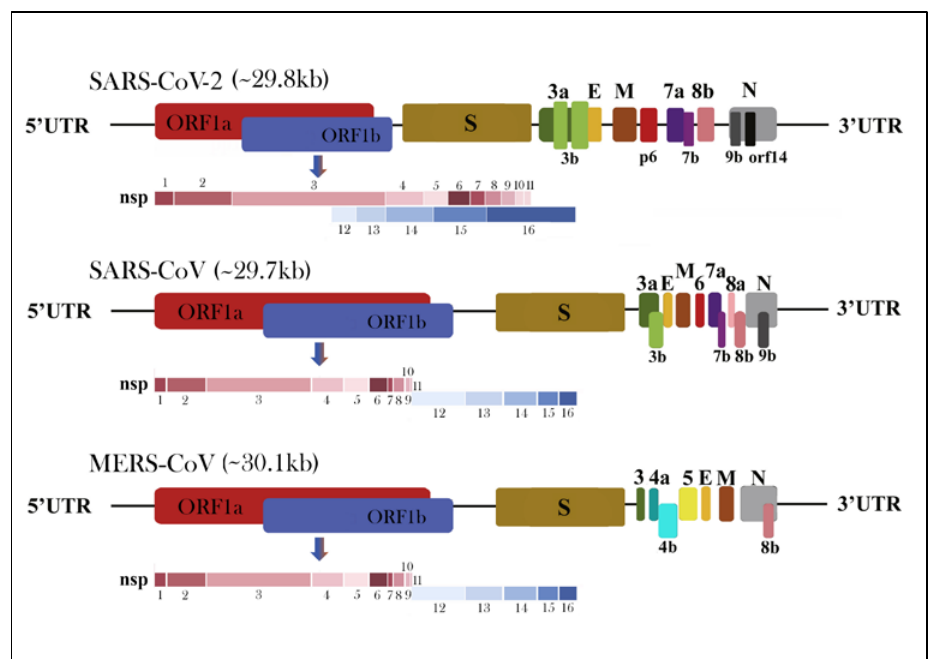
Figure 4. Graphic genome structures of SARS-CoV-2, SARS-CoV and MERS-CoV. Each coronavirus (CoV) genome is schematically represented in the order of 5′ -ORF1a-ORF1b-S-E-M-N- 3′. The coronavirus genomes encode two replicase polypeptides pp1a and pp1ab translated from ORF1a and ORF1b; four structural genes encoding for four structural proteins including (S) spike, (M) membrane, (E) envelope and (N) nucleocapsid proteins. The single-stranded RNA genomes of SARS-CoV-2 (~29.8 kb), SARS-CoV (~29.7 kb) and MERS-CoV (~30.1 kb) harbor two large genes, the ORF1a (red) and 1b (blue) genes encoding accessory genes (nsps 1–16, shades of red and blue). Encoded nonstructural proteins: 16 nsps (nsp1-nsp16) in SARS-CoV-2, SARS-CoV and MERS-CoV. Along with structural proteins (S, E, M and N), the 3′ -terminus of the SARS-CoV-2 and SARS-CoV genomes contain eight accessory proteins (3a, 3b, p6, 7a, 7b, 8b, 9b and orf14 and 3a, 3b, p6, 7a, 7b, 8a, 8b and 9b, respectively) while MERS-CoV genome contains only five (3, 4a, 4b, 5 and 8b). The genes encoding accessory proteins are unique in different coronaviruses in terms of number, genomic organization, sequence and functions (data extracted from [35,49,57]). Table 1. Host factors(s) involved in SARS-CoV, MERS-CoV and the SARS-CoV-2 replications [4,15]. Replication Stage Host Receptor